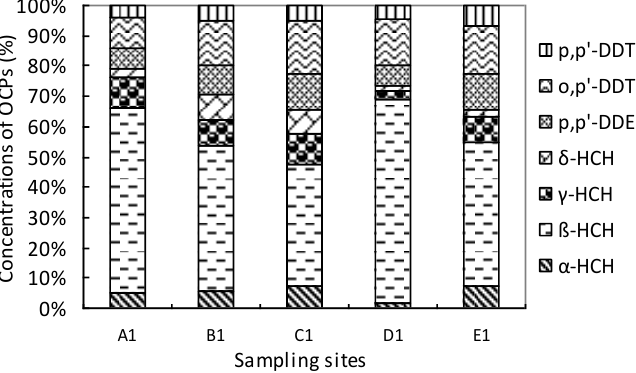
Fig. 3. The composition profiles of OCPs in park dust samples from Ulaanbaatar